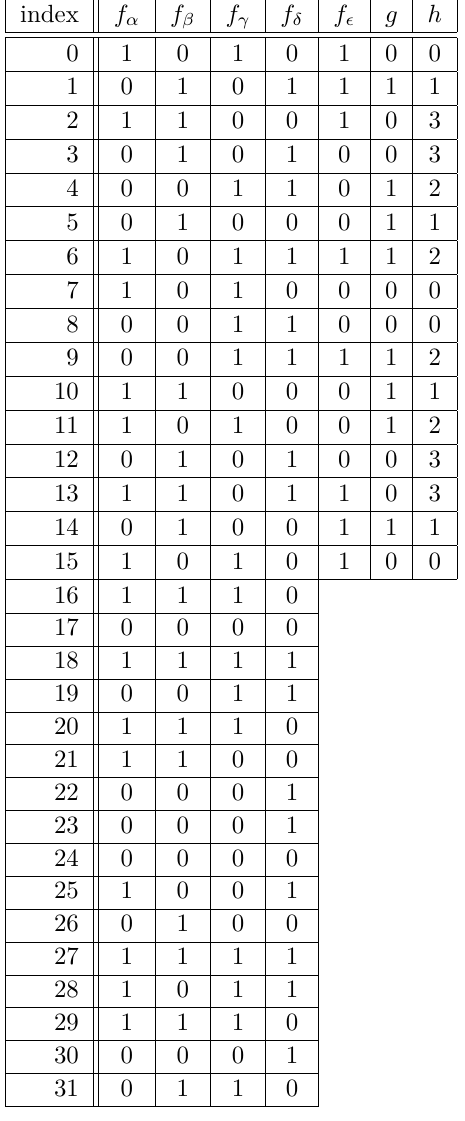
Table 5: The tables used in the Feistel function